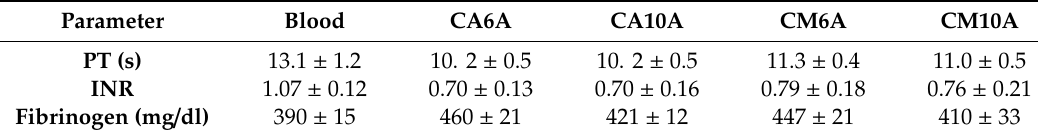
Table 5. PT, INR and fibrinogen